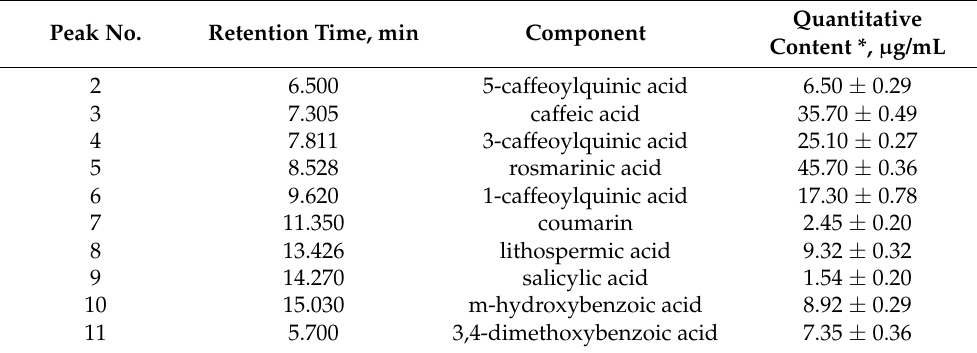
Table 3. Component composition of the aqueous-alcoholic extract of Symphytum officinale , containing type II polymer, according to HPLC data.